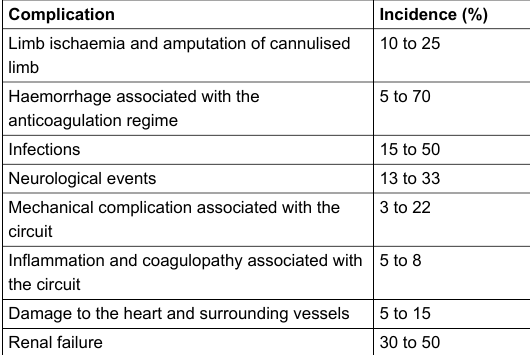
Table 1: Complications associated with extracorporeal life support in